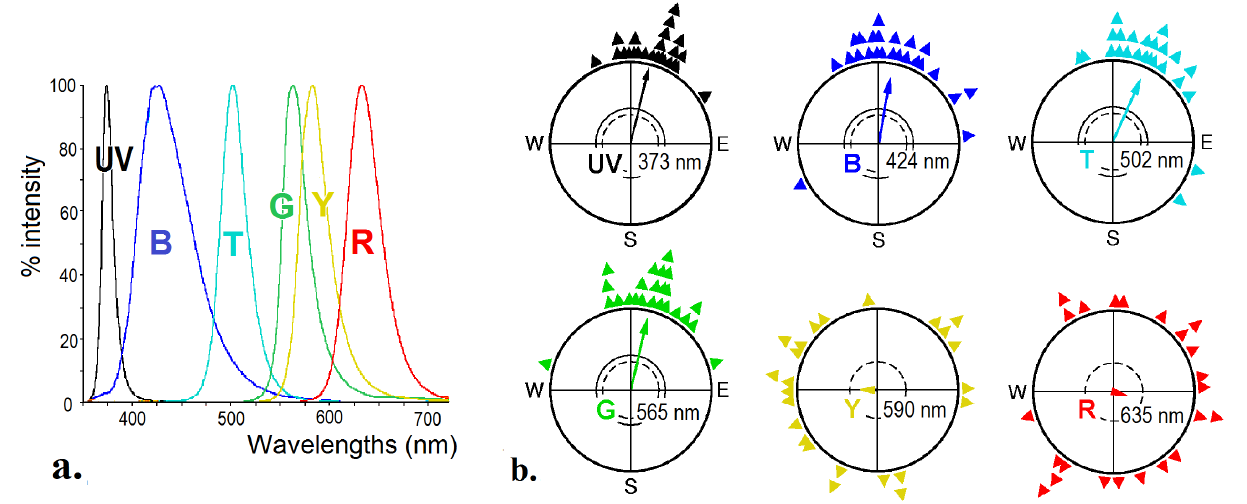
Figure 4. Orientation of robins under narrow band-lights of various wavelengths. ( a ) Spectra of the test lights produced by light-emitting diodes. ( b ) Orientation behavior under the various lights, with the peak wavelength indicated in the figure. The light intensity was about 8 × 10 15 quanta/s·m 2 , except under UV, where it was only 0.8 × 10 15 quanta/s·m 2 .— Symbols as in Figure 1b (data from